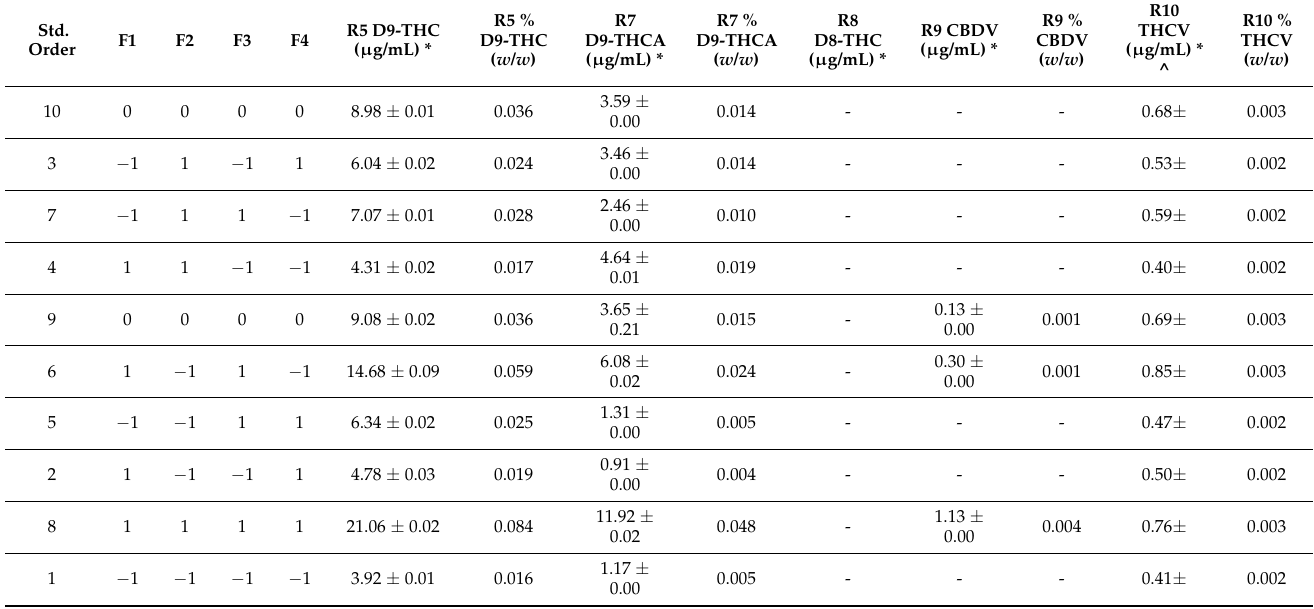
Table 6. HPLC quantification for delta 9-tetrahydrocannabinol (D9-THC), delta 9- tetrahydrocannabinol acid (D9-THCA), delta 8-tetrahydrocannabinol (D8-THC), cannabidivann (CBDV), and tetrahydrocannabivann (THCV) in the supercritical carbon dioxide extract.